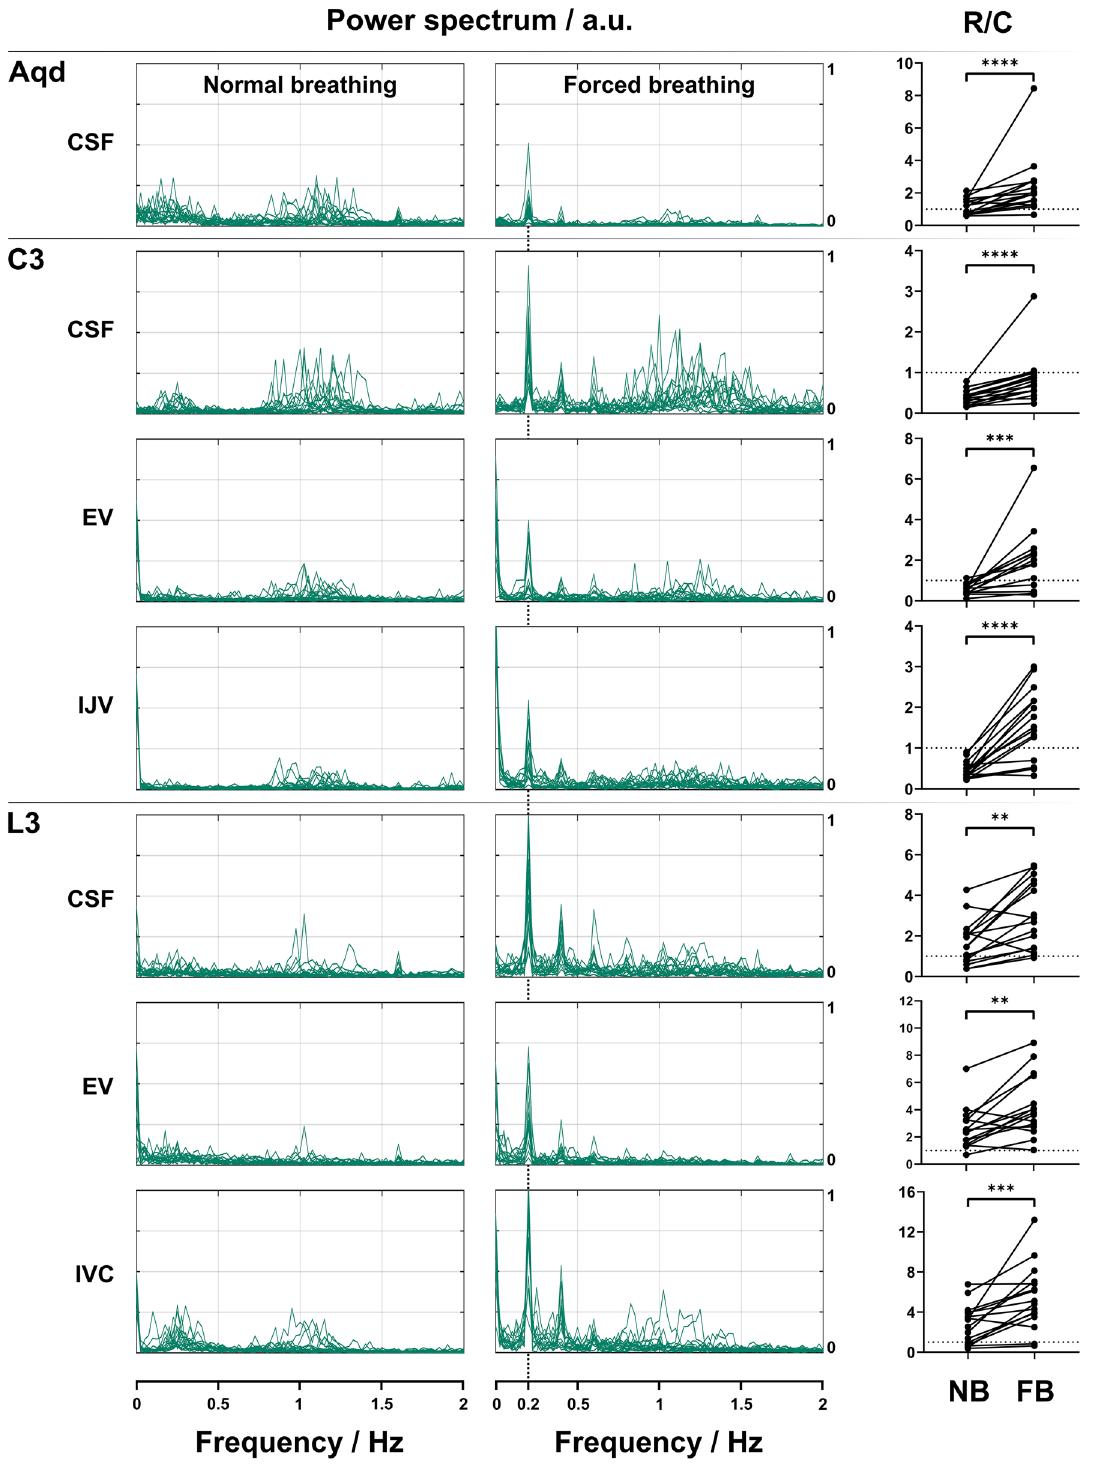
Figure 6. Frequency analysis of CSF and venous flow. Frequencies (Hz) spectrum of flow signals of 16 subjects during normal (left column), forced breathing (middle column) and power ratio R/C (right column). Note the predominance of frequencies corresponding to heart rates during normal breathing for CSF (Aqd, C3) and C3 venous flow and R/C values < 1 (right column). During forced breathing frequencies of 0.2 Hz (5 s = one breathing cycle in the protocol) and 0.4 Hz (2.5 s = half a breathing cycle) dominated at all locations in both fluid systems with corresponding R/C values > 1 except for C3-CSF. Here, the frequencies related to heart rates and the R/C remained < 1. In all localizations R/C values increased significantly from normal to forced breathing. Aqd = aqueduct, C3 = cervical level 3, L3 = lumbar level 3, EV = epidural veins, IJV = internal jugular vein, IVC = inferior vena cava, R/C = respiration/cardiac, NB = normal breathing, FB = forced breathing, ns = not